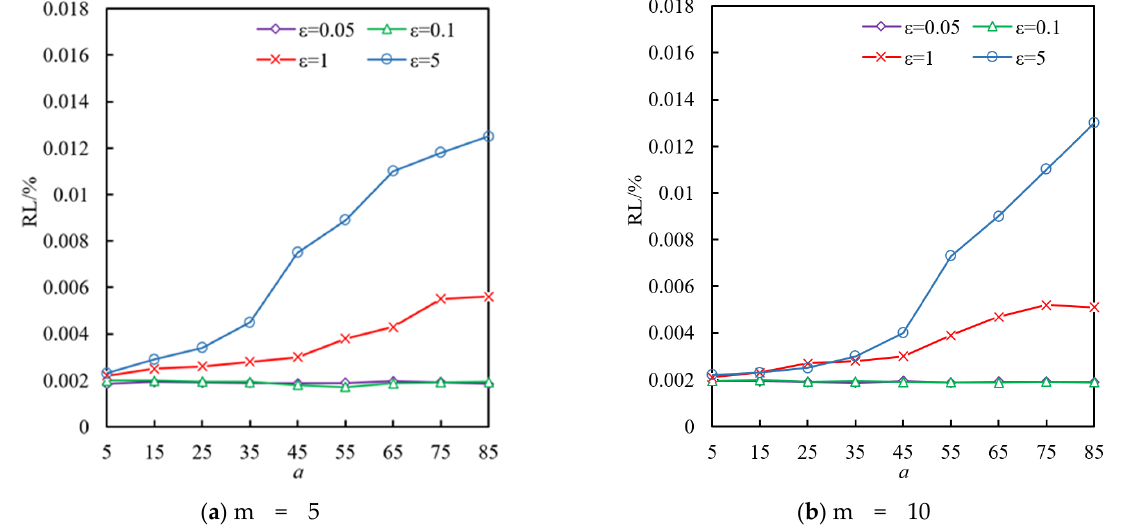
Figure 6. Change trend of RL for the Adult data.